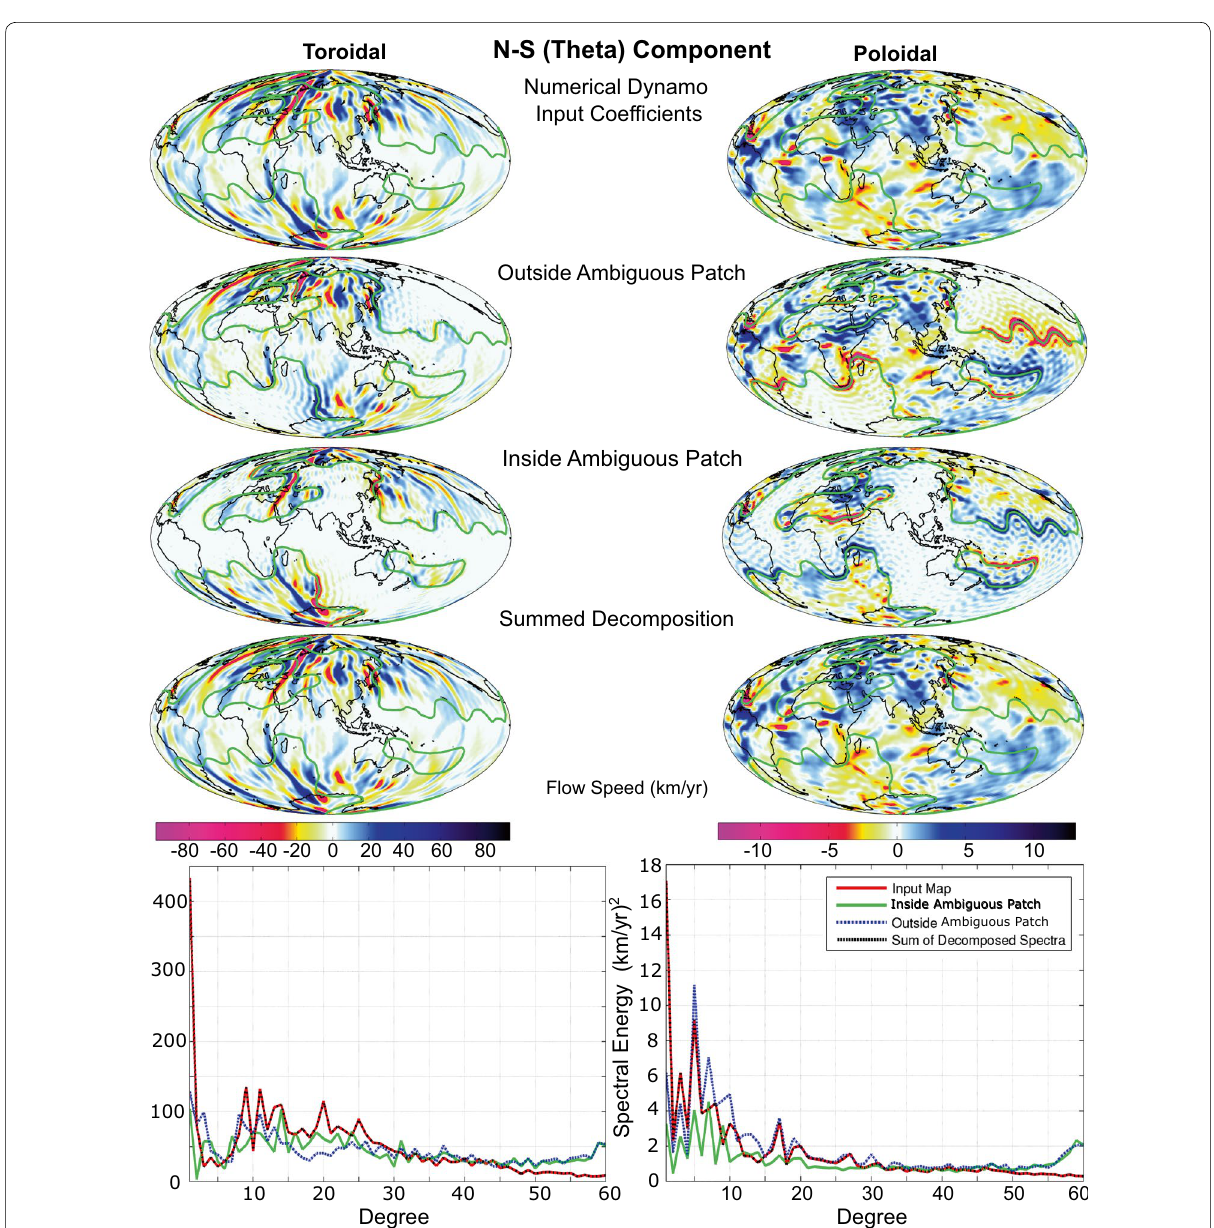
Fig. 5 Decomposition of numerical dynamo flow simulation in southward direction ( u θ ). Decomposition of a snapshot flow from a numerical model using the coefficients up to degree 60 (3721 coefficients) using the Shannon number ( K ambiguous